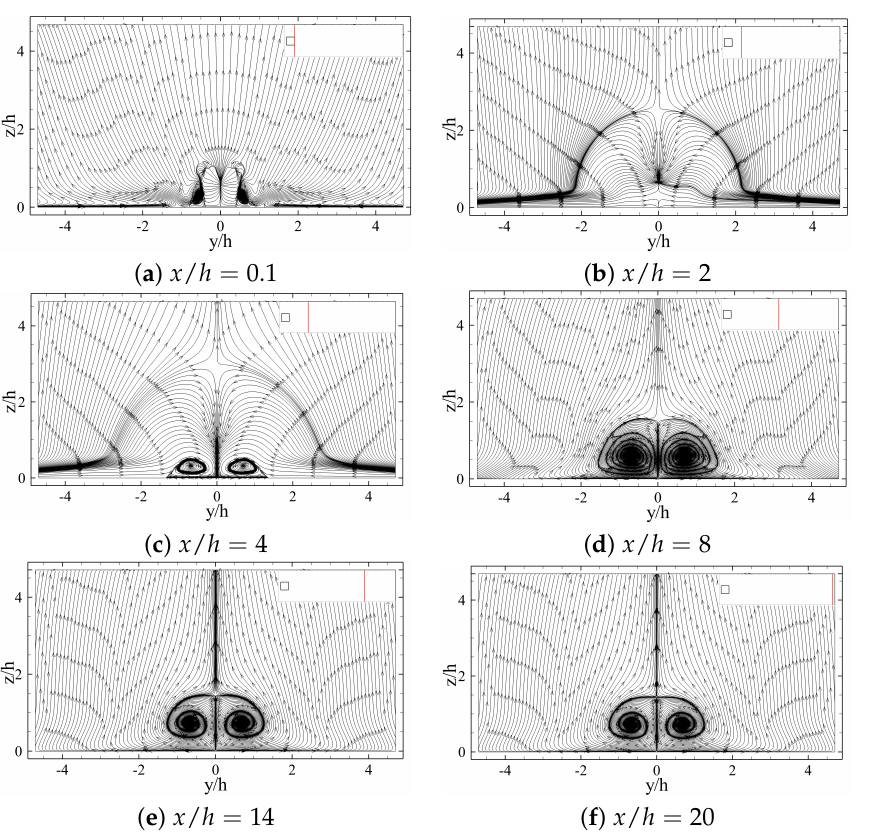
Figure 21. Mean streamlines on cross-sectional ( yz -) planes at different distances from the square prism.